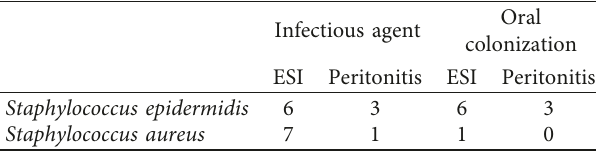
Figure 1: Staphylococcus oral colonization of PD patients and healthy controls and Staphylococcus agents responsible for PD-related infections. Common species are in bold. Figure was produced using Servier Medical Art, Table 7: Comparison between peritoneal infections, peritonitis, or exit-site infections (ESI) caused by Staphylococcus species and oral colonization of PD patients.